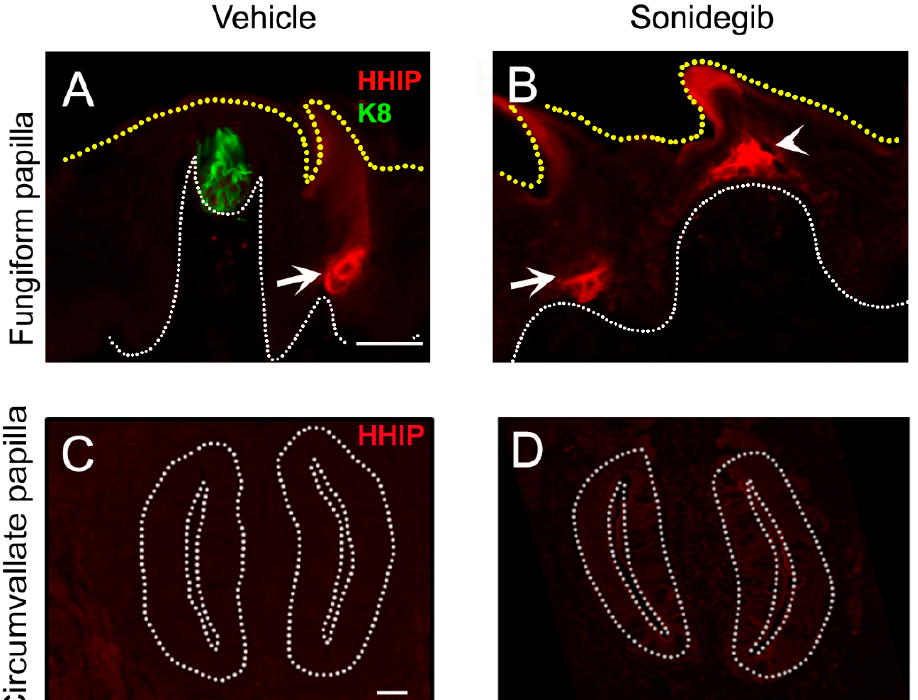
Figure 6. HH antagonist HHIP expression in fungiform and circumvallate papillae. ( A – D ) Antibody detection of endogenous HHIP (red) after vehicle ( A , C ) and sonidegib ( B , D ) treatment. ( A , B ) In the anterior tongue papillae, HHIP is expressed in the non-taste filiform papilla (white arrow) but not in the fungiform papilla or within the taste bud (green, K8) ( A ). After HH pathway inhibition with sonidegib, HHIP is ectopically expressed at the fungiform papilla apex (white arrowhead) ( B ). ( C , D ) In the circumvallate papilla there is no HHIP expression in the vehicle tongue ( C ). Unlike the fungiform papilla, ectopic HHIP is not observed after sonidegib exposure ( D ). White dotted lines demarcate basal lamina and yellow dotted lines mark the tongue surface in subfigures ( A , B ). White dotted lines in subfigures ( C , D ) outline the circumvallate papilla walls. Scale bar (50 μ m) in ( A ) applies to ( A , B ) and ( C ) applies to ( C , D ).